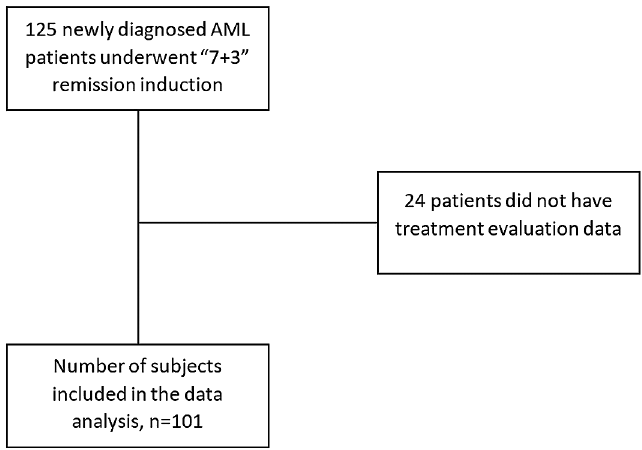
Figure 1. Research subject recruitment